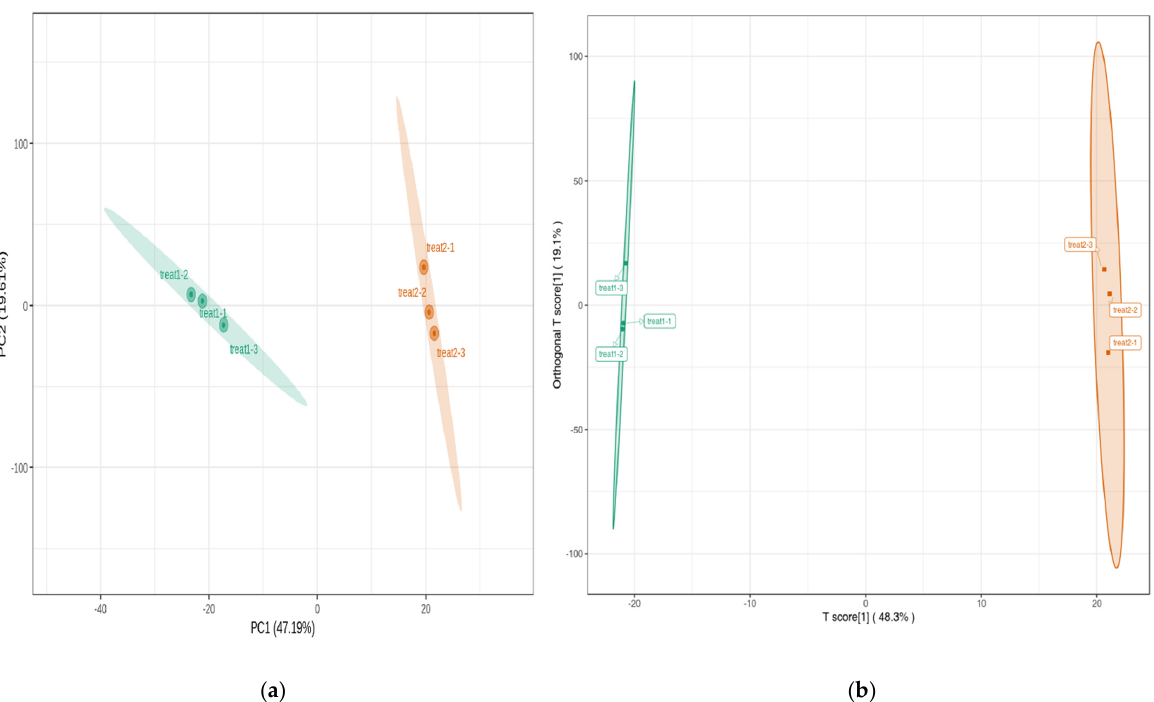
Figure 3. ( a ) Principal component (PC) biplot for the PC1 and PC2 reveal the overall variation between the cultivars in terms of metabolomic profiles. ( b ) Orthogonal partial least squares discriminant plot for the chile pepper cultivars. Treatment 1: ‘NuMex LotaLutein’; treatment 2: ‘NuMex Pumpkin Spice’. Numbers 1, 2, and 3 correspond to the first, second, and third biological replications, respectively.